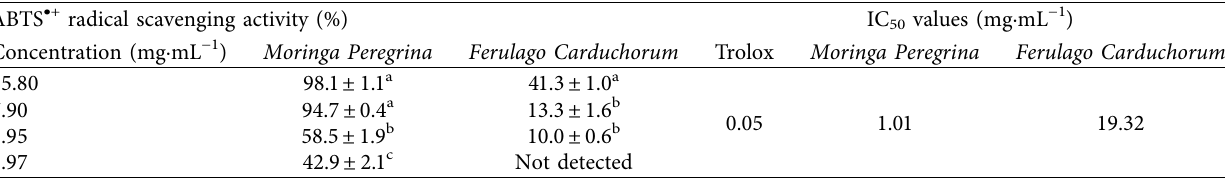
Table 2: Antioxidant properties of Moringa peregrina and Ferulago carduchorum ethanolic extracts 1 . ABTS • + radical scavenging activity